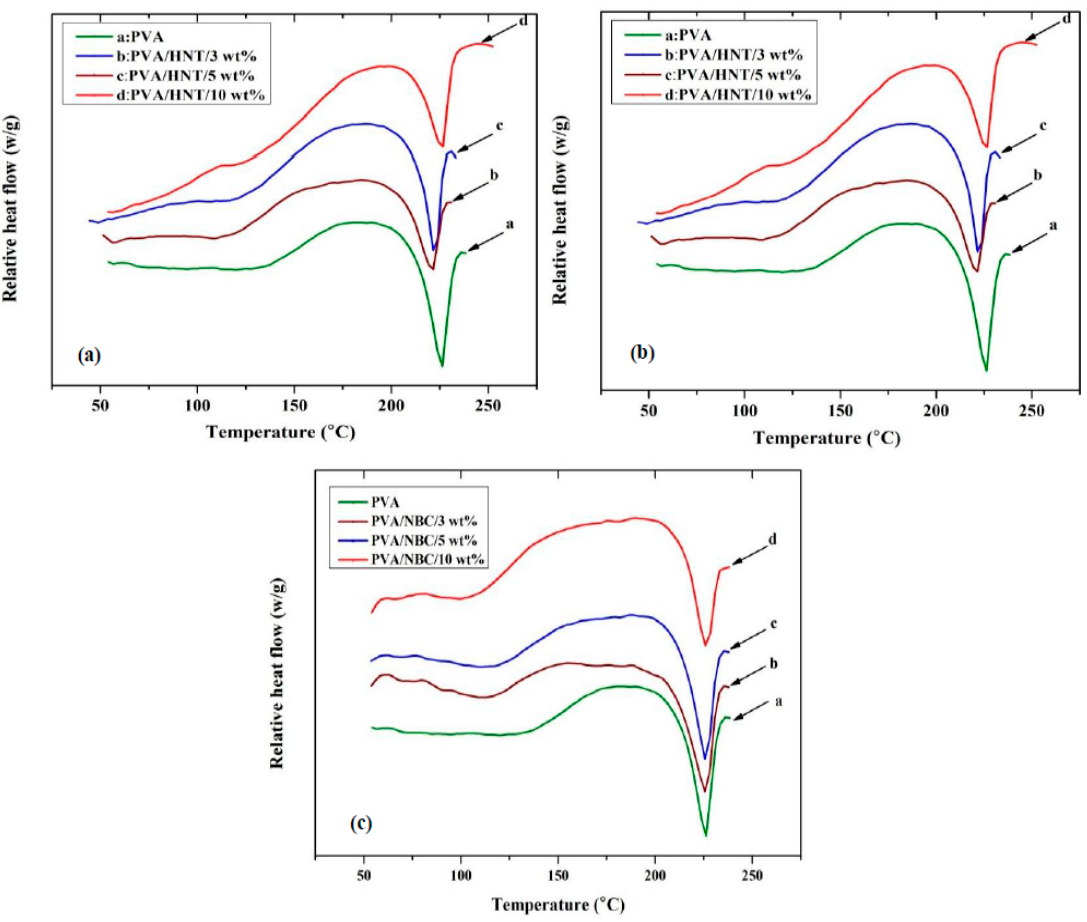
Figure 9. Differential scanning calorimetry (DSC) thermograms of PVA bionanocomposites reinforced with ( a ) HNTs, ( b ) Cloisite 30B clays, and ( c ) NBCs. The curves are shifted vertically for clarity.